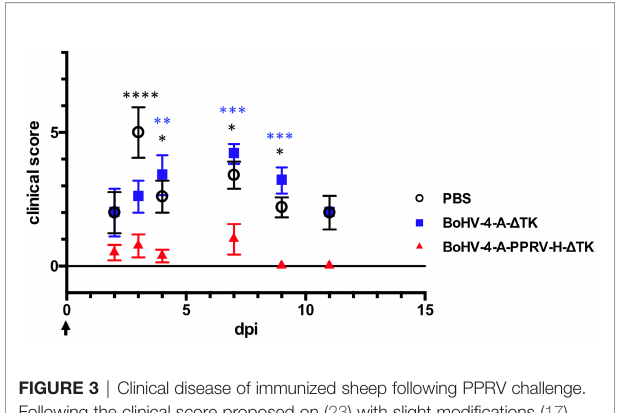
FIGURE 3 | Clinical disease of immunized sheep following PPRV challenge. Following the clinical score proposed on (23) with slight modi fi cations (17), the graded clinical observation for the development of disease after PPRV challenge in immunized sheep was represented. Data are presented as average (± SEM) score for different days post-challenge (dpi) for each treatment group as indicated in the legend. Differences were found to be signi fi cant (* p < 0.05; ** p < 0.005; *** p < 0.0005; **** p < 0.00005; two-way ANOVA) between control (PBS or BoHV-4-A- D TK) and vaccinated group from days 3 to 8 post-challenge.